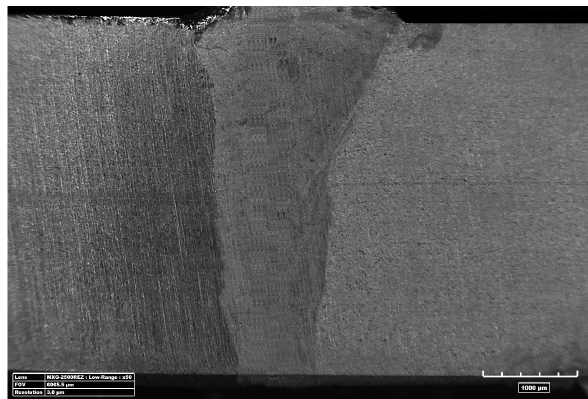
Figure 7: Trial laser welded but joint in cross section